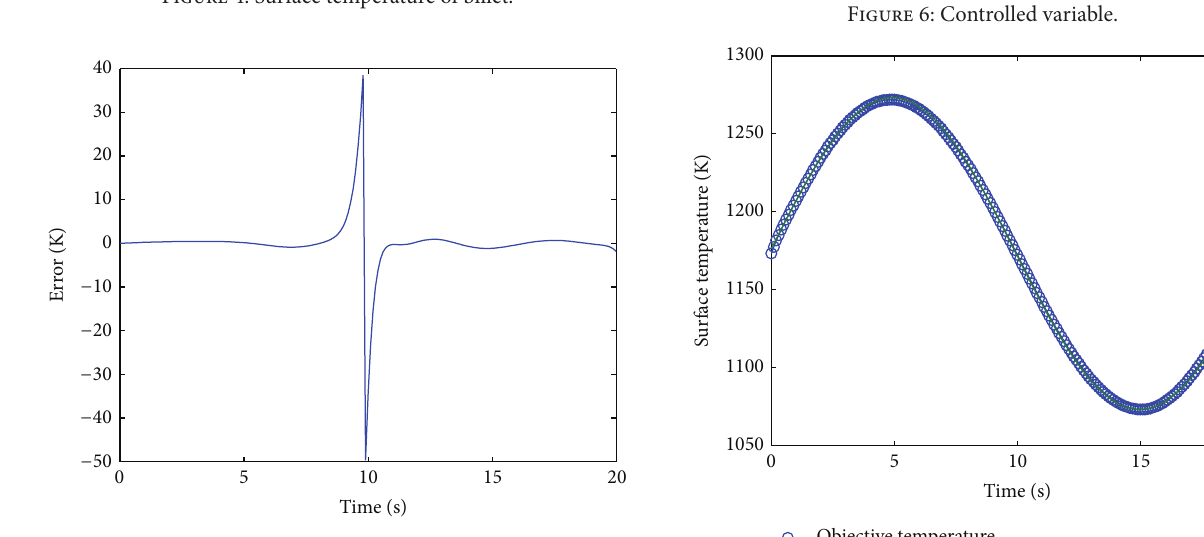
Figure 5: Surface temperature error of billet.